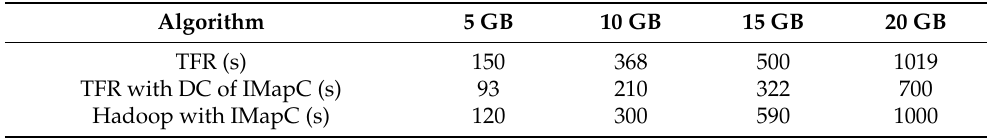
Table 7. Performance Comparison of TFR, TFR with DC of IMapC, and Hadoop on running Sort program.